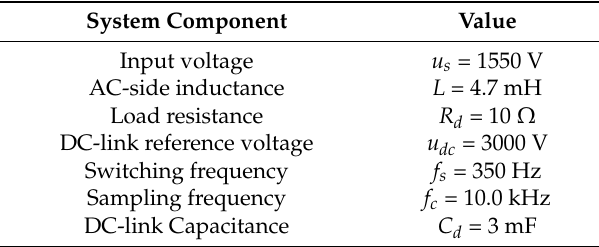
Table A2. Component parameters of the EMUs’